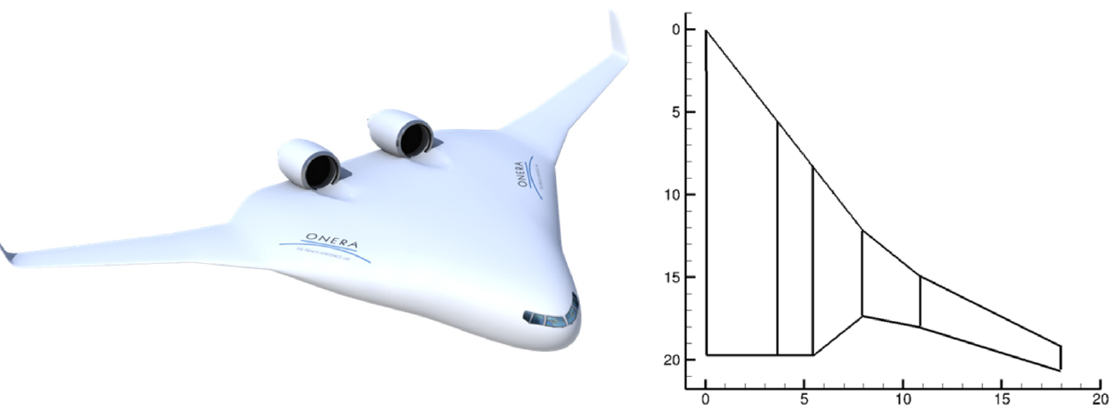
Figure 32. SMILE BWB configuration—data used by the aerodynamic module (6 wing sections).